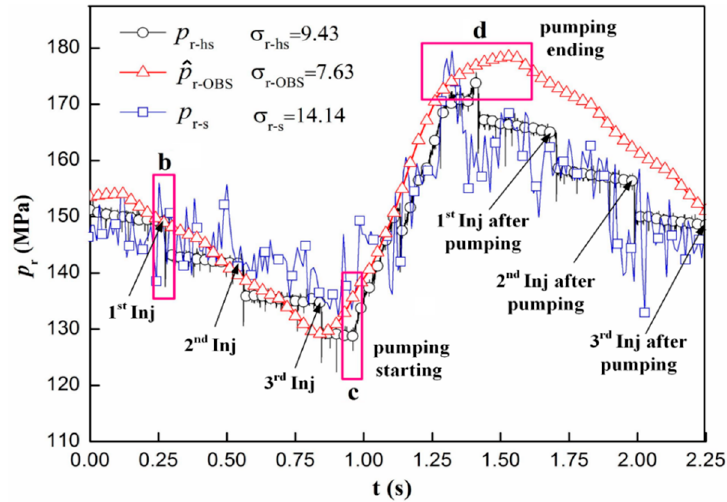
Figure 4. Evolution of measured rail pressures for p r − hs , and ˆ p r − OBS in the same pumping–injection cycle. p t = 150